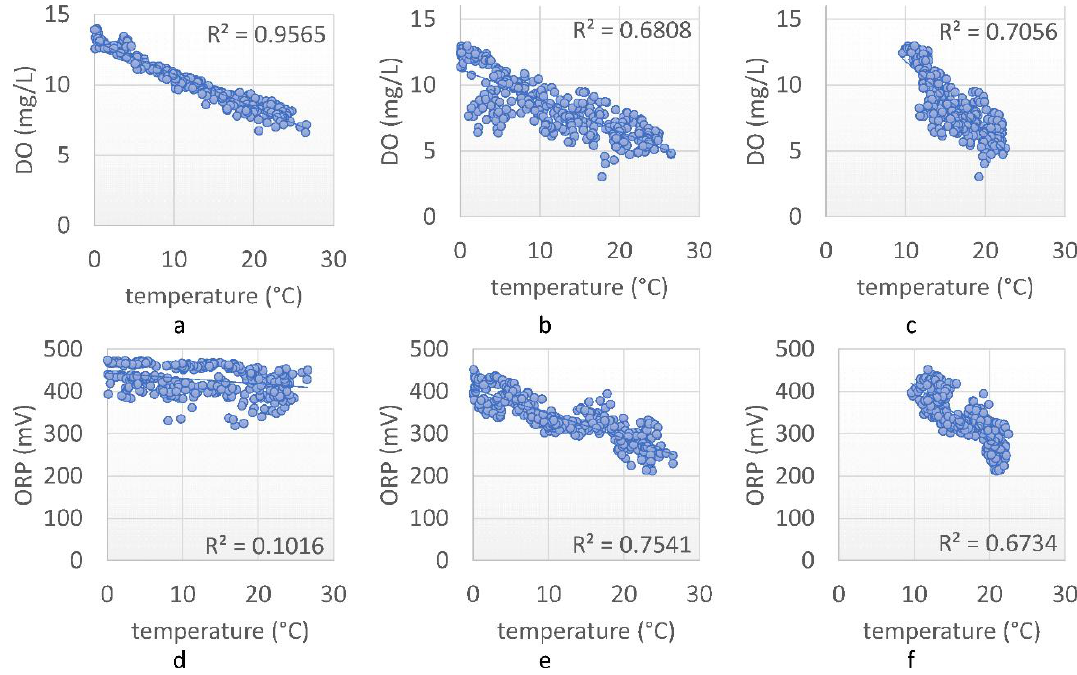
Figure 3. Scatter plots of two parameters (first row—DO; second row—ORP) monitored at Mihoveni (upstream) and Tişăuţi (downstream) and the temperature of various types of waters: ( a , d )—streamwater upstream; ( b , e )—streamwater downstream; ( c , f )—wastewater temperature of wastewater treatment plant of Suceava city (WWTP) effluent vs. Suceava River DO or ORP downstream (linear trendline and coefficient of determination included).